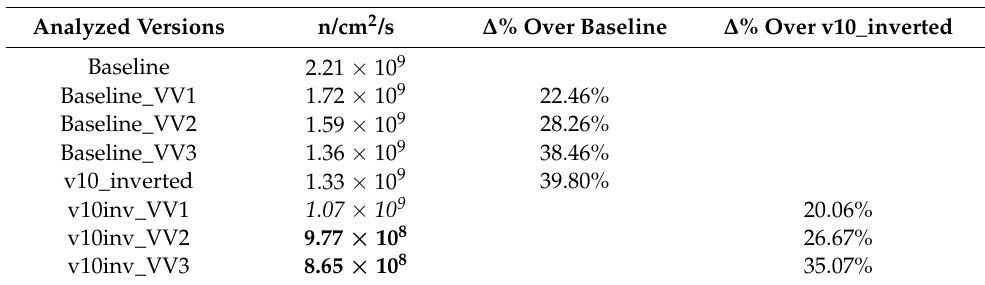
Table 9. Neutron flux at first radial cm of the TFC for the baseline and v10_inverted versions with modified VV.